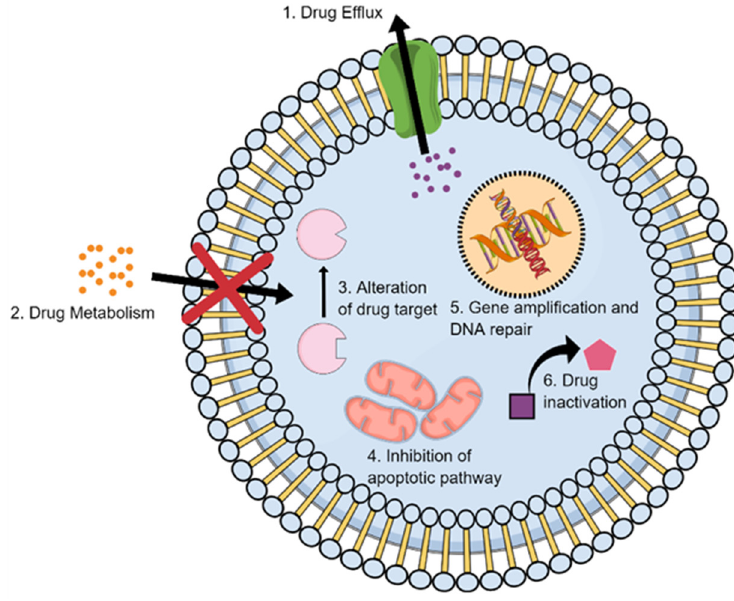
Figure 4. Different mechanisms of DR in LC.